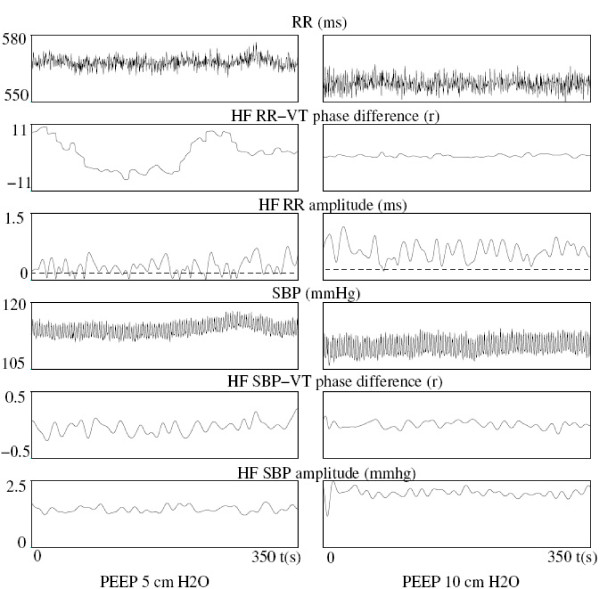
Comparison of the CDM parameters between PEEP 5 and PEEP 10 in a subject representative of the mean behavior of all patients. This subject exhibited great differences as he was classified in the unstable group at PEEP 5 and reclassified in the stable group at PEEP 10. So, the figure mainly focused on the greater variability of the HF phase and amplitude of RR and SBP, at PEEP 5. This greater variability was estimated by the standard-deviation of the time series, the maximal drift of the phase, the percentage of time spent below the amplitude threshold (dashed line).